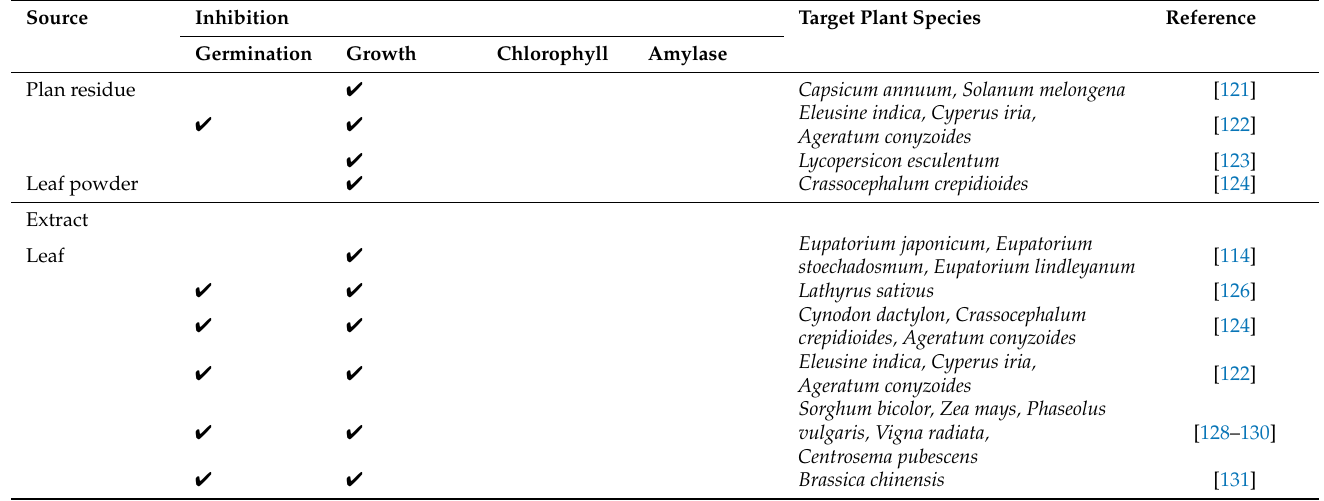
Table 4. Allelopathic activities of C. odorata